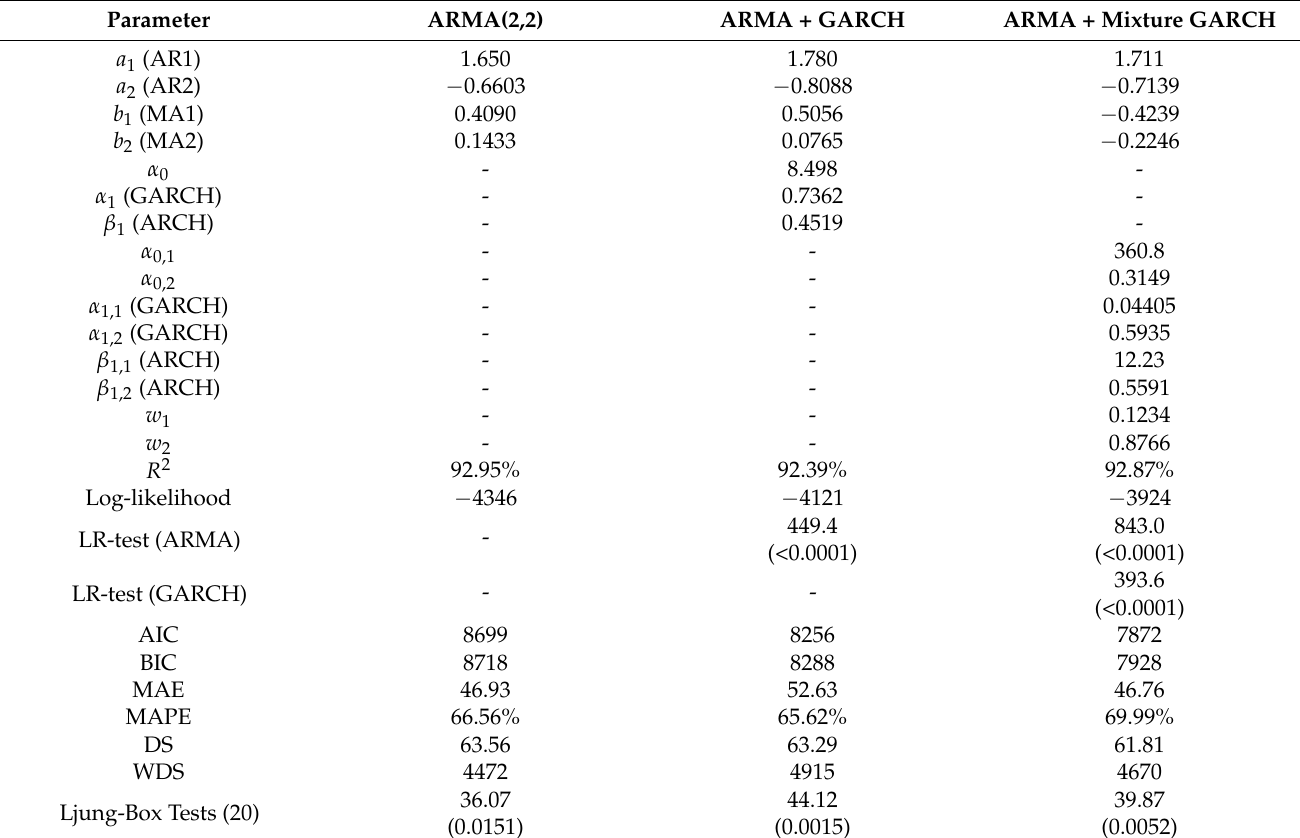
Table 4. Estimated parameters and performance measures for the first wind generation